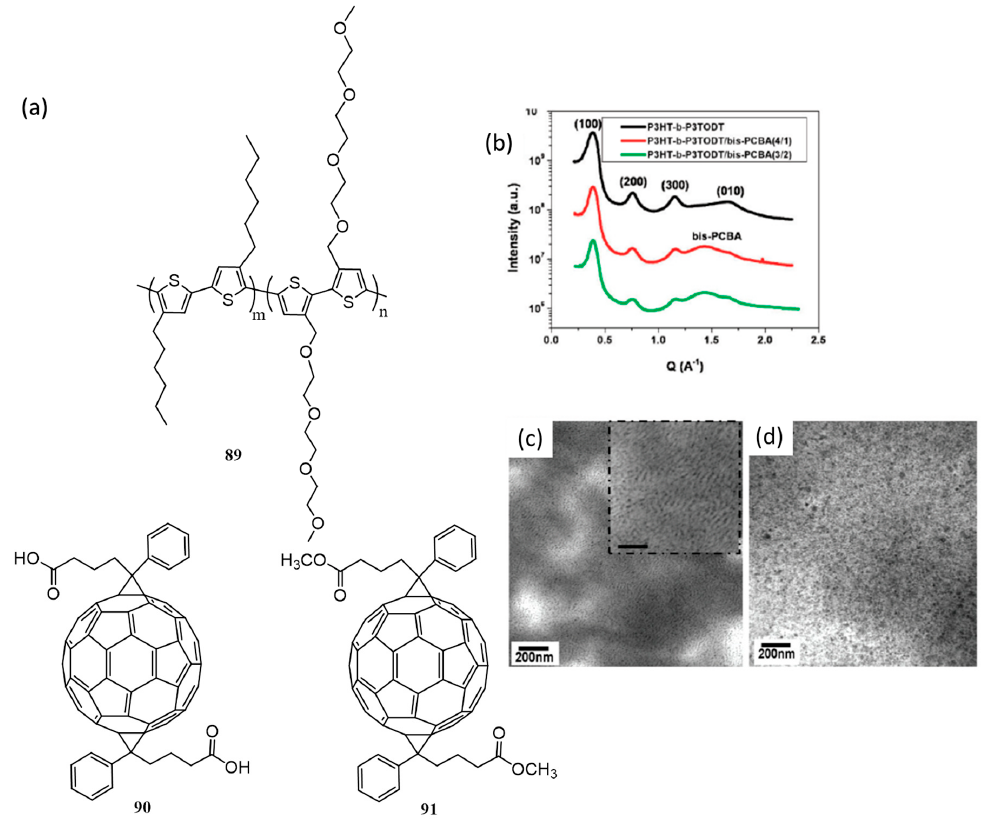
Figure 30. ( a ) Chemical structures of 89 – 91 synthesized by Watkins et al. [106]. ( b ) Overlay of GIXRD out-of-plane diffractograms of 89 and its blends with different ratio of 90 . TEM images of ( c ) 89 / 91